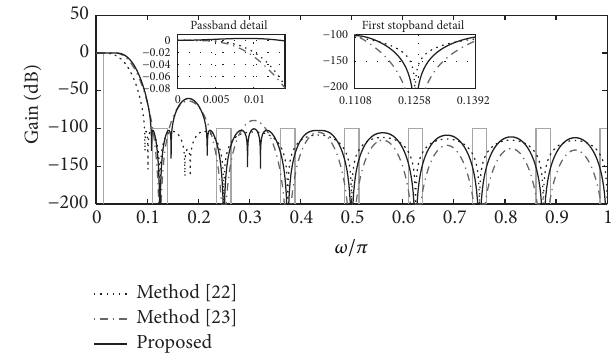
Figure 3: Magnitude responses of the filters 𝐻 𝑎 (𝑧) (method [22]), (𝑧) (method [23]), and 𝐻 (𝑧) (proposed method), presented in 𝐻 𝑏 𝑐 Example 1 with 𝑀 = 16 , 𝜐 = 4 , and 𝜔 𝑝 = 0.907 𝜋/(𝑀𝜐) .